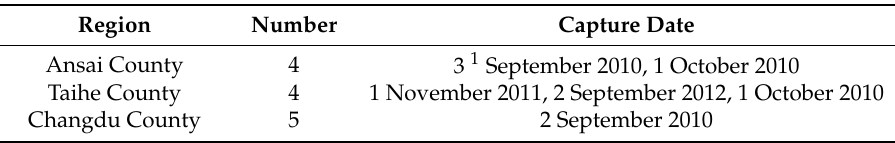
Table 2. Image number and capture